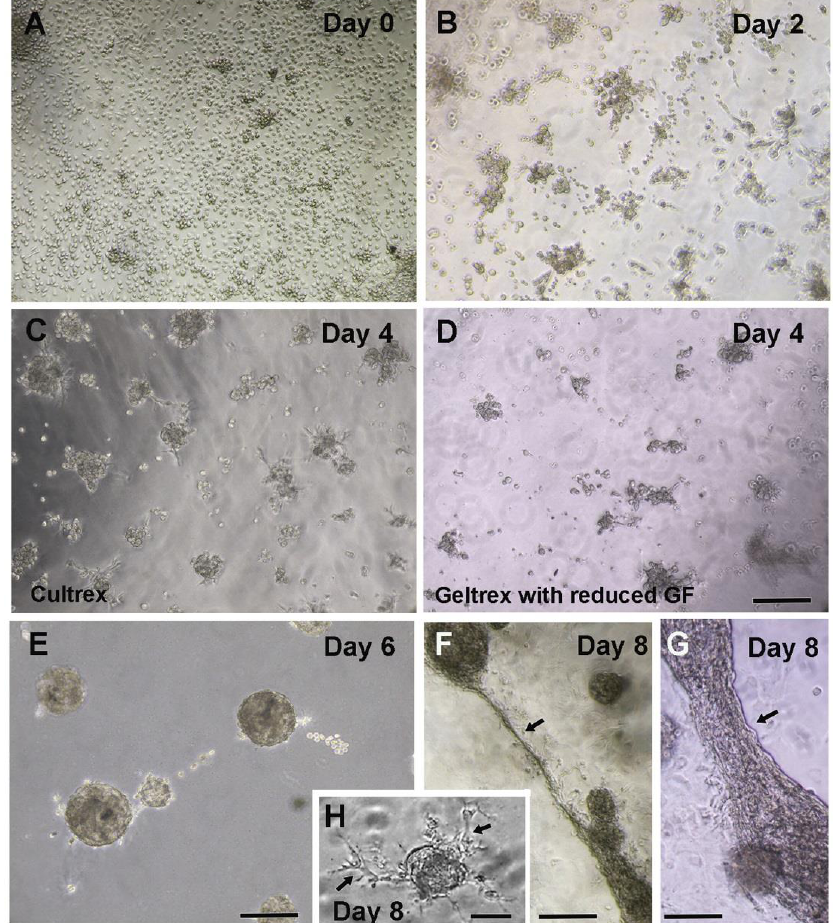
Figure 1. Representative 3-D culture images showing E11.5 embryonic ventricular cells in “cells over the matrix bed method” using Cultrex BME with regular growth factors ( A – C , E – H ) or Geltrex BME with reduced growth factors ( G , F ) ( D ). ( A ) At day 0, cells are uniformly spread over the matrix immediately after plating. ( B ) At the day 2 stage of culture, cells start to gather and form small clusters. ( C , D ) Day 4 stage of cultures show formation of larger or smaller spheroid cell bodies in Cultrex BME ( C ) and Geltrex BME with reduced GF ( D ). ( E ) At day 6, fibrous extensions begin to form between cell bodies. ( F ) At day 8, spheroid cells bodies are connected by contracting thin ( F ) or thick ( G ) filamentous structures indicated by arrows. ( H ) In addition to connecting fibers, spheroid cell bodies also develop multiple fibrous outgrowths/extensions at day 8 (indicated by arrows). Note: for panel ( H